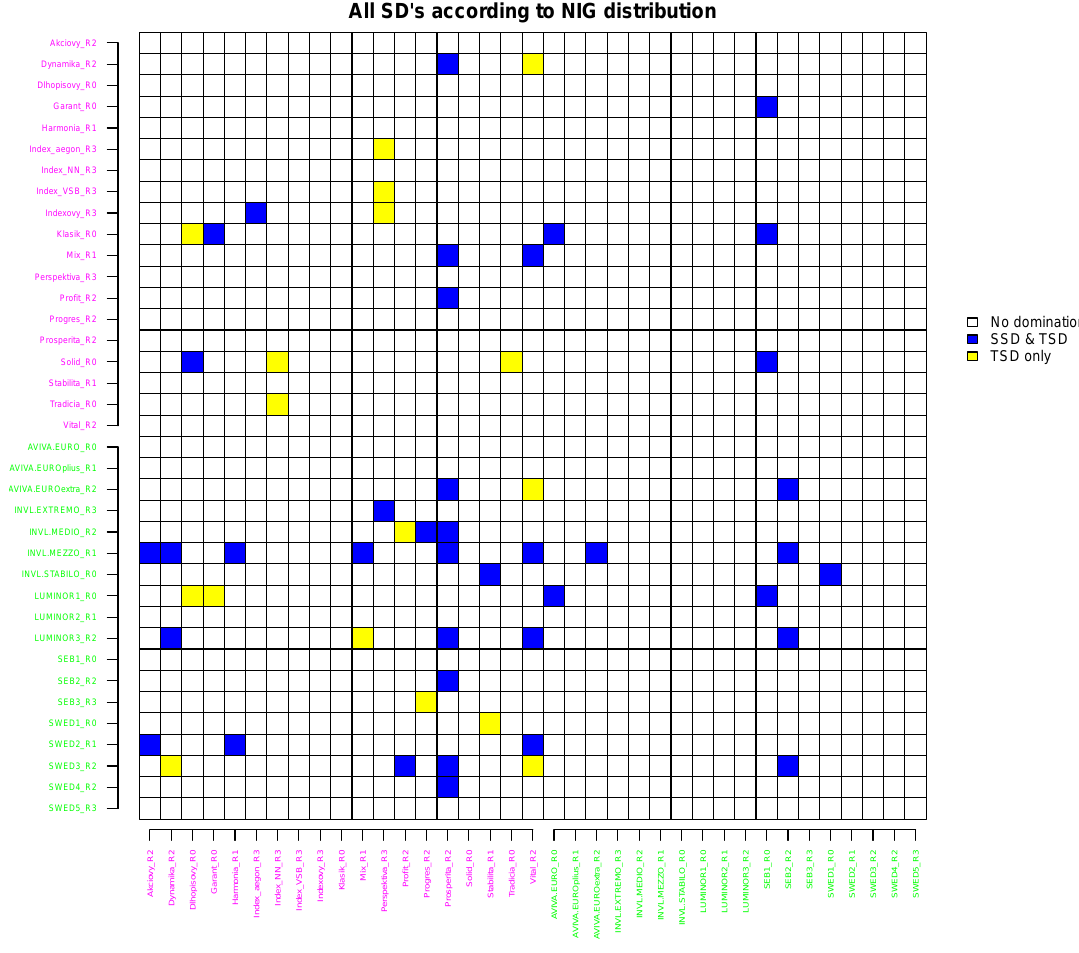
Figure 10. SD relations for all PFs assuming NIG